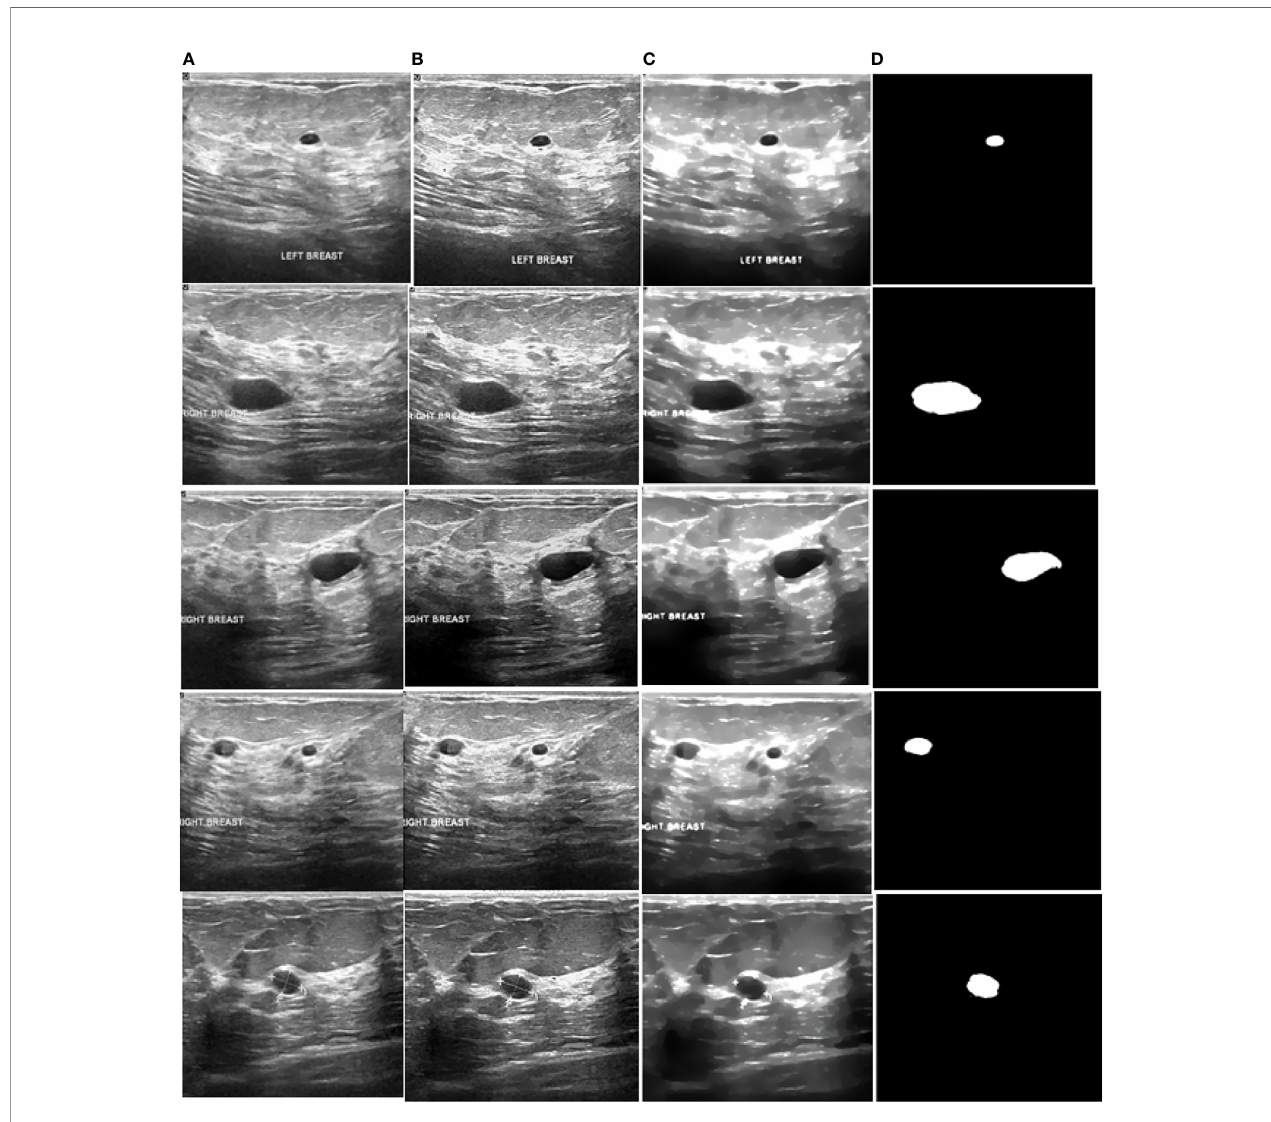
FIGURE 9 | Processed benign images. (A) US image, (B) enhancement, (C) despeckling, and (D)